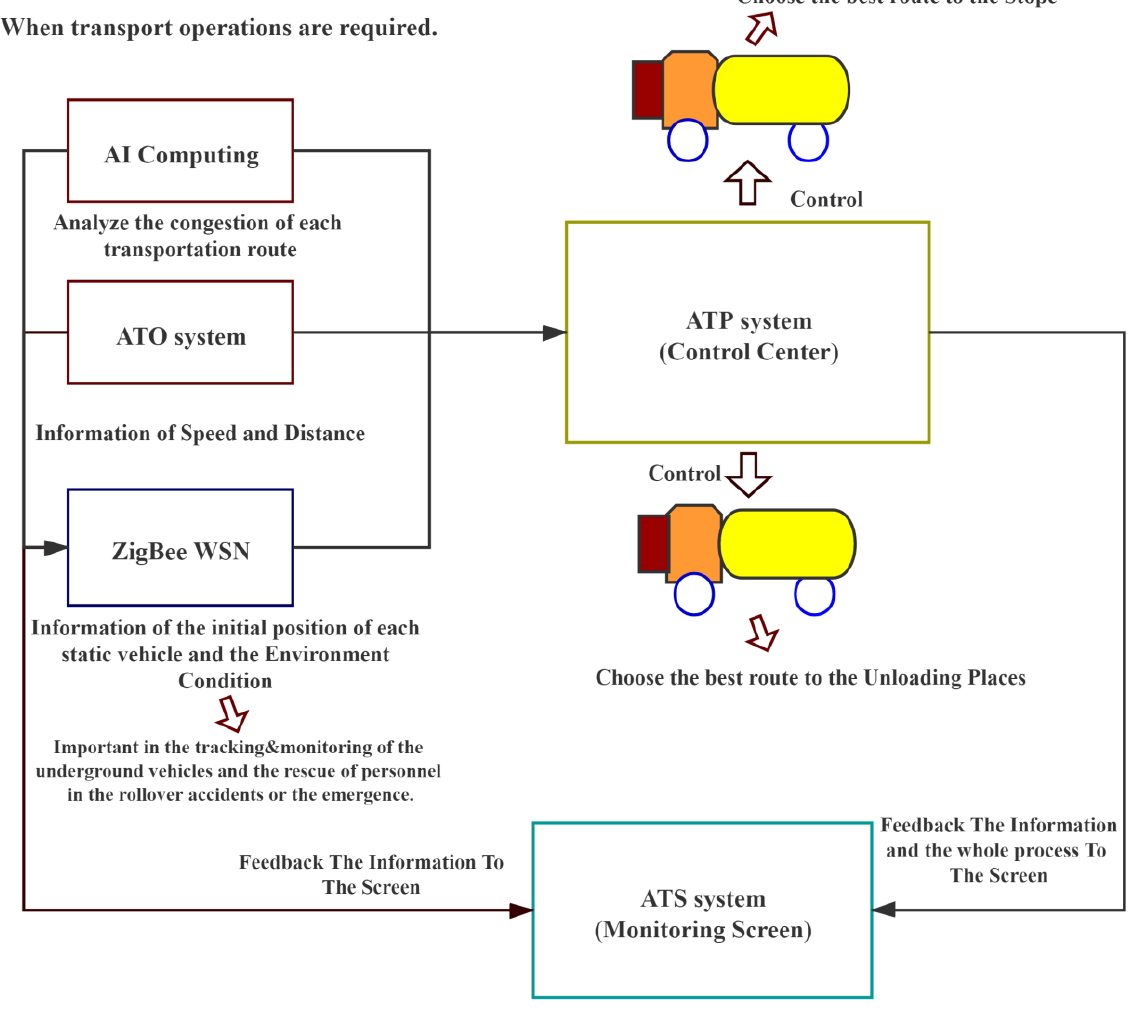
Figure 4. The process logic diagram of the solution to the scheduling problems.